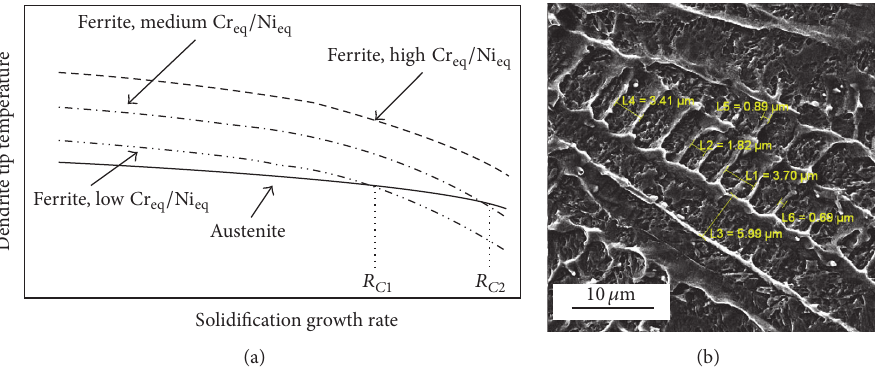
Figure 13: The SDAS and DAS sizes for EBW weld zone for sample number 3.